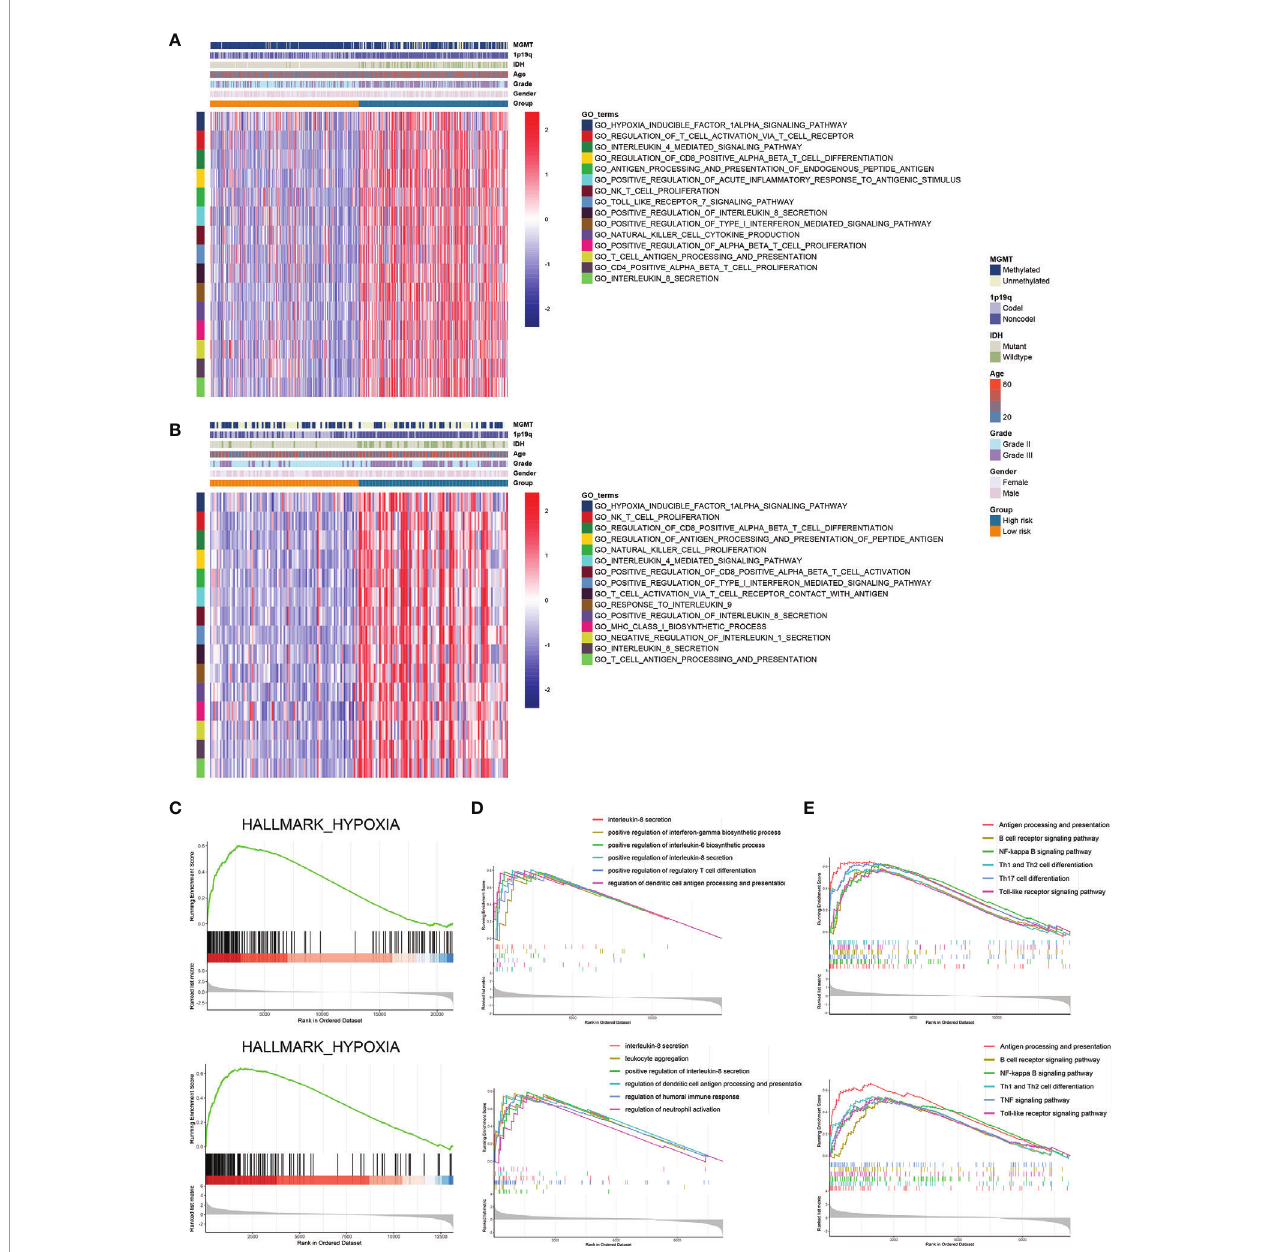
FIGURE 5 | Risk strati fi cation exhibited distinct immune characteristics. (A, B) GSVA analysis of hypoxia and immune pathways in high-risk and low-risk groups in the TCGA (A) and CGGA (B) datasets. (C) Differentially expressed genes between high-risk and low-risk groups were enriched in hypoxia-related pathways. (D, E) GSEA analysis of differentially expressed genes between high-risk and low-risk groups in GO (D) and KEGG (E)